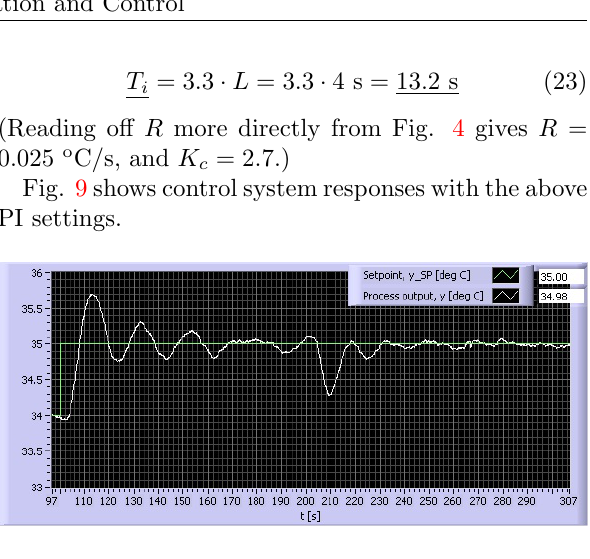
Figure 9: Ziegler-Nichols’ Process Reaction Curve method: Responses in the control